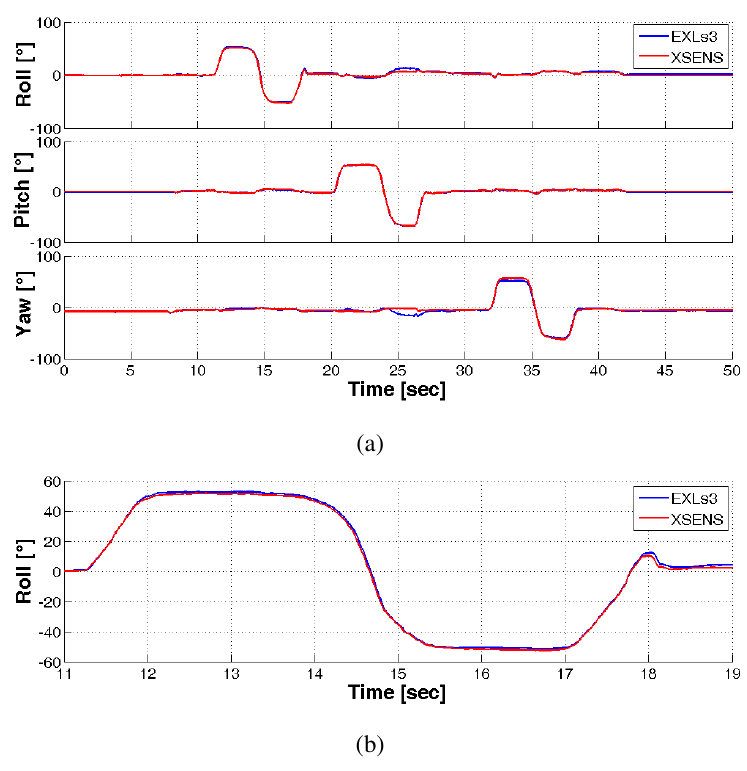
Figure 4. ( a ) Comparison of orientation estimation as computed by Xsens MTw (red) and EXLs1 (blue) sensor nodes using the Kalman filter. ( b ) Zoom of the roll